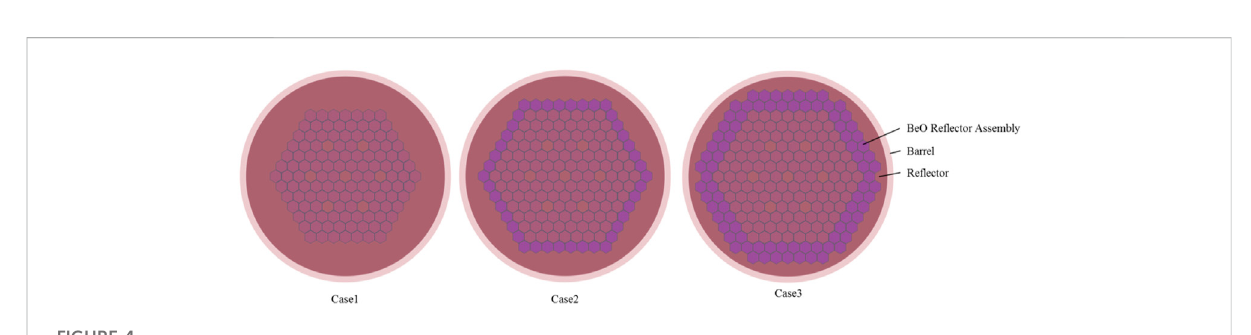
FIGURE 4 Radial core con fi guration in the re fl ector